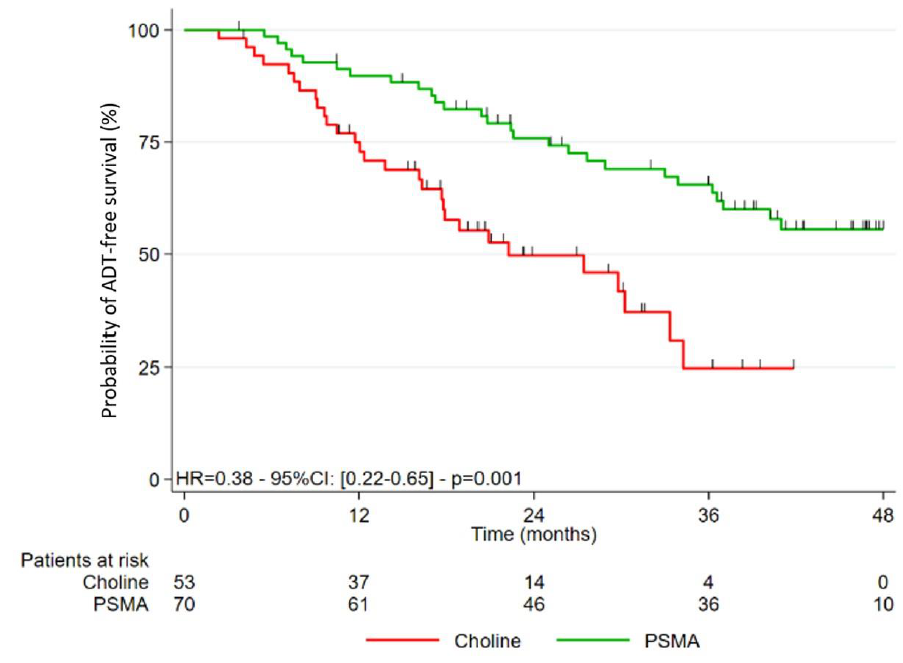
Figure 2. Kaplan-Meier survival curve without ADT (ADT-FS).